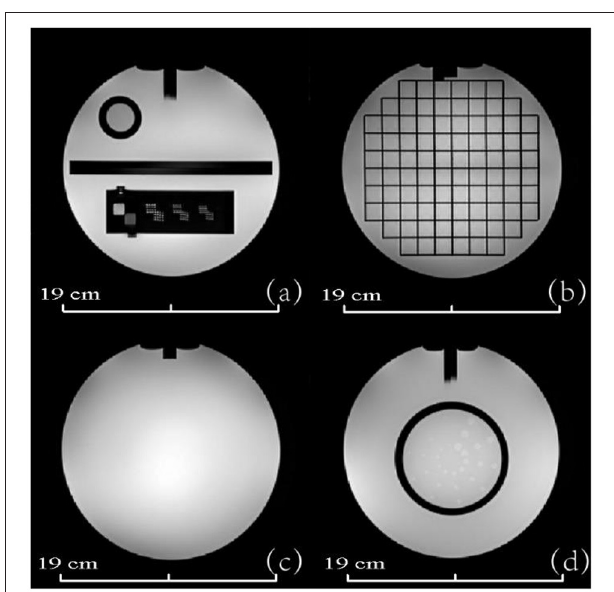
FIGURE 7 | MRI images of the ACR MRI phantom. (a) Layer thickness and high contrast resolution module (b) geometric distortion test module (c) image uniformity module (d) low contrast test module. Phantom dimensions are marked in the